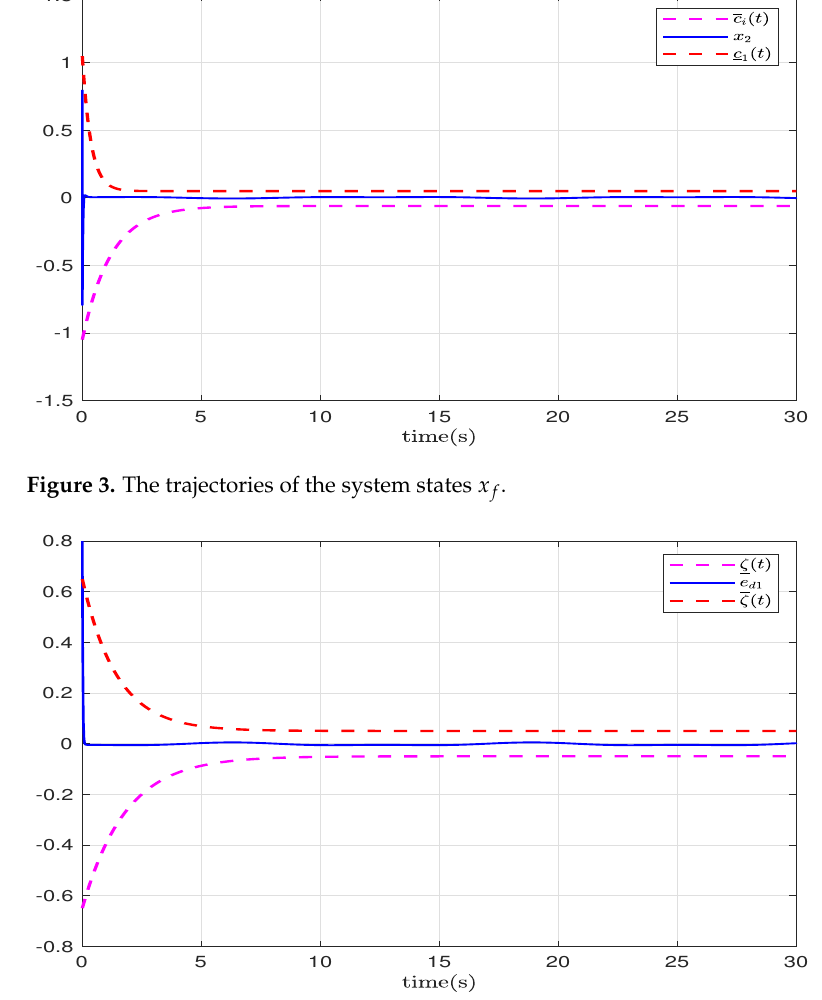
Figure 4. The curve of the tracking error e d 1